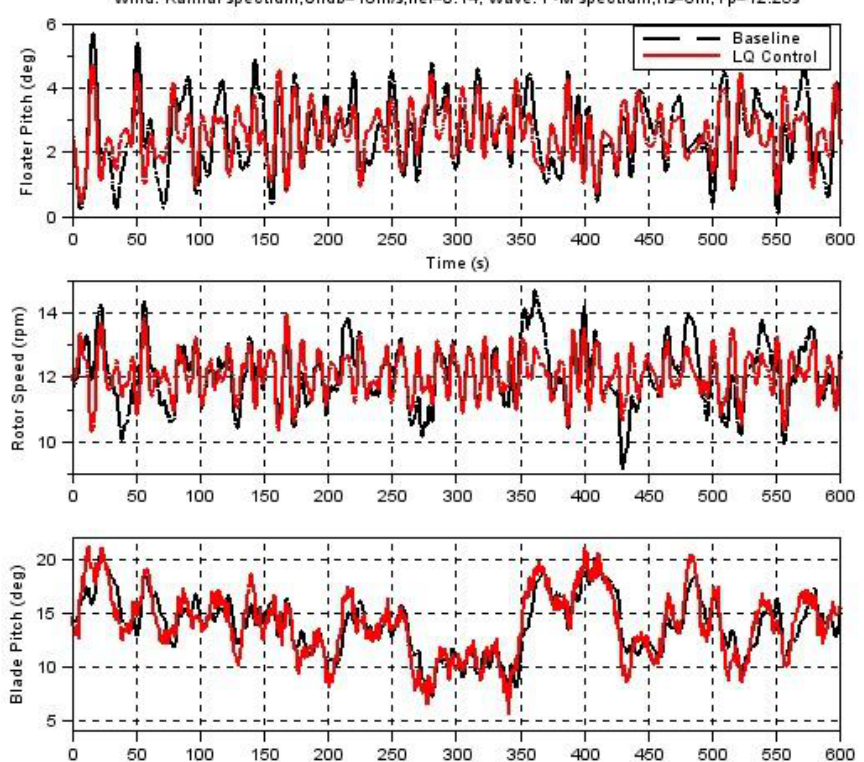
J. Mar. Sci. Eng. 2018 , 6 , x Figure 5. LQ control of a spar FOWT—rough sea state. Figure 5. LQ control of a spar FOWT—rough sea state.